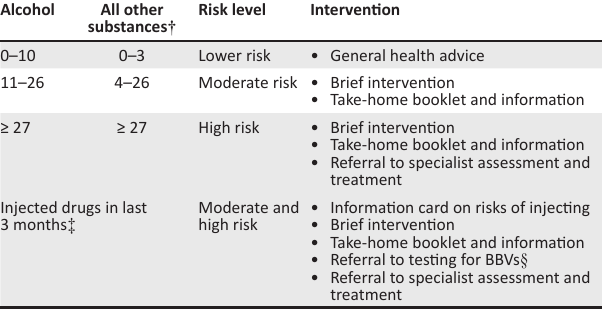
TABLE 9: Alcohol, Smoking and Substance Involvement Screening Test risk score and associated risk level and intervention. 45 Alcohol